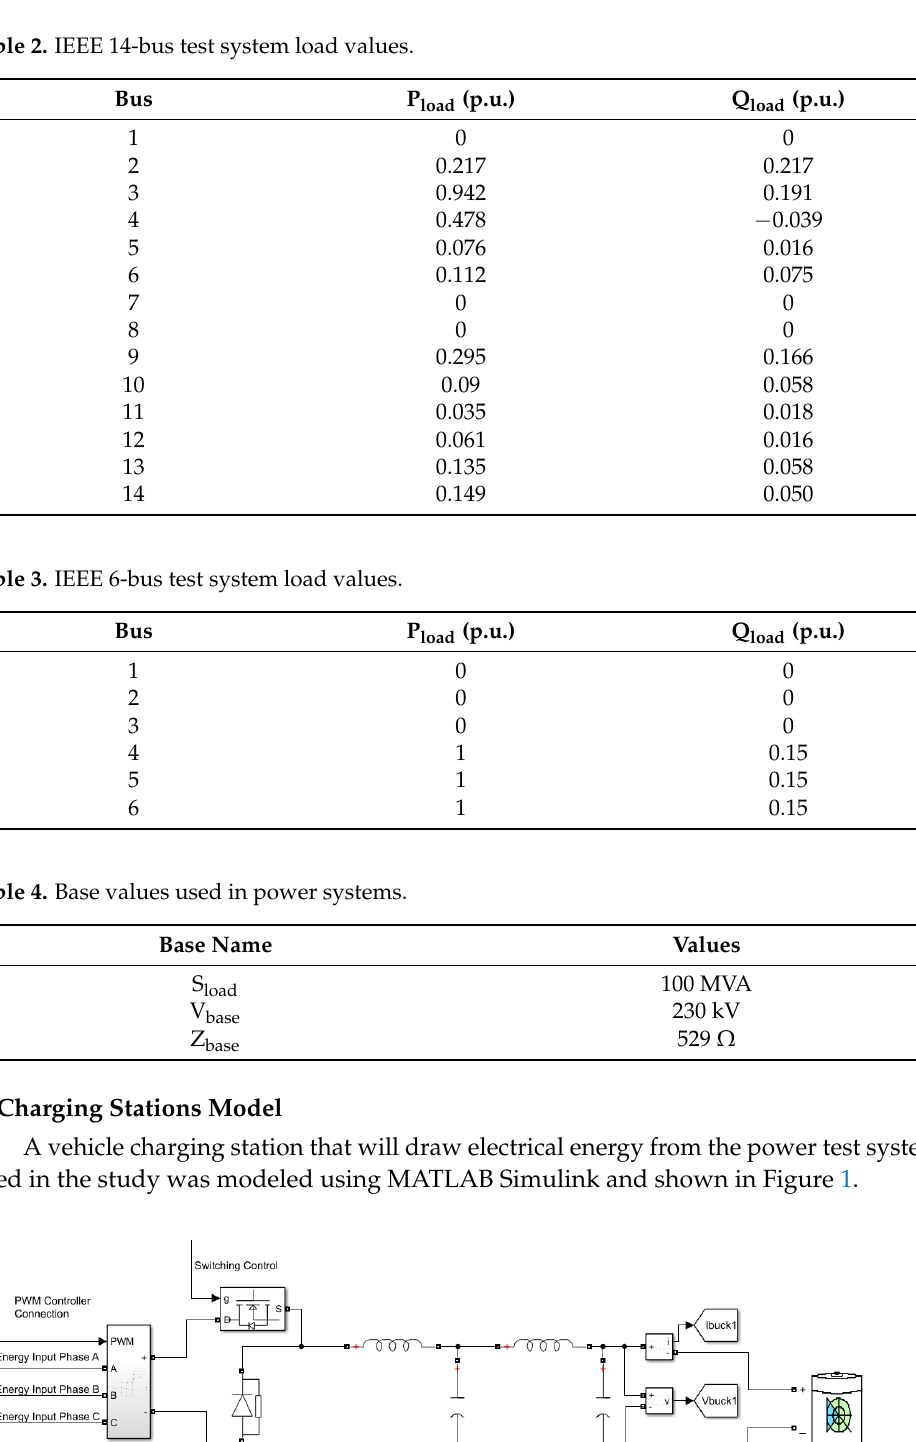
Table 2. IEEE 14-bus test system load values.